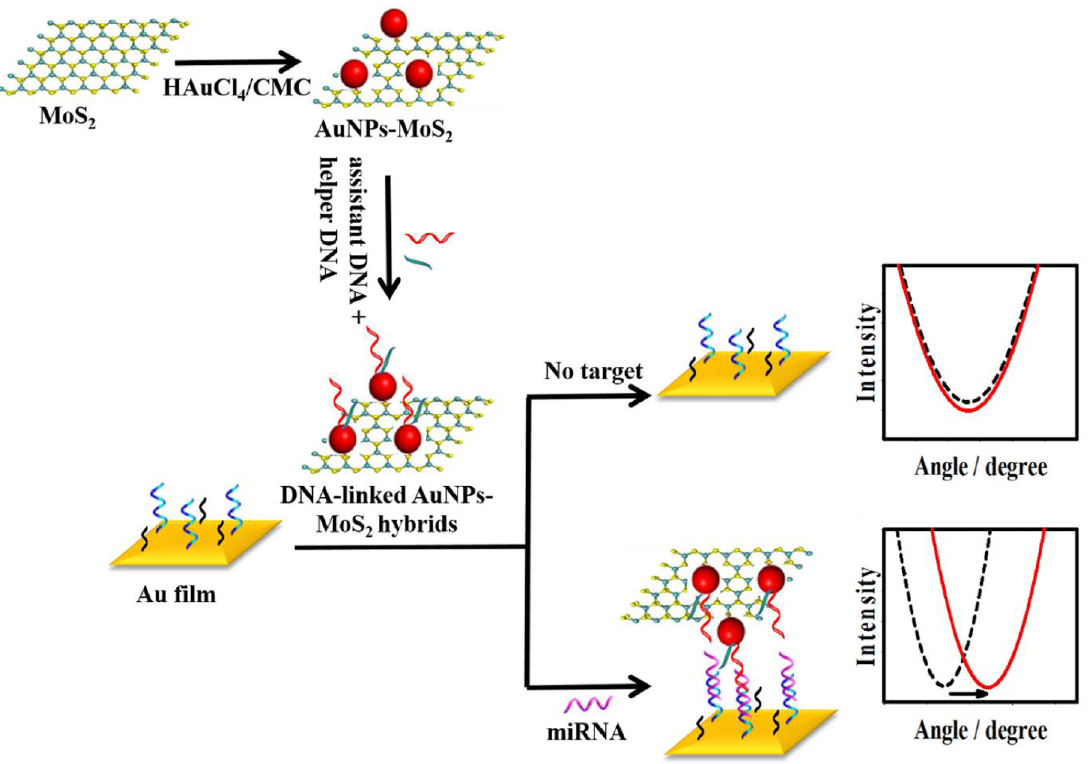
. Reproduced with permission from [169] Copyright @ 2